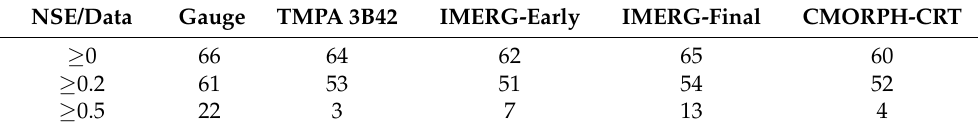
Table 1. NSE statistics.